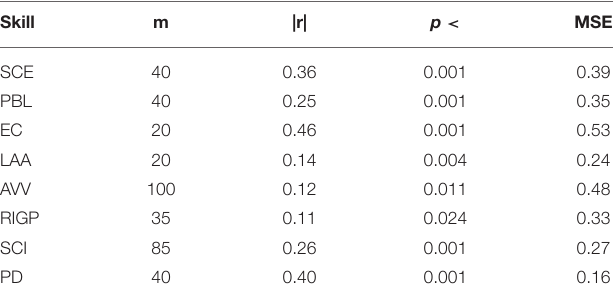
TABLE 2 | Best GP regression model results and number of clusters for each presentation delivery skill, using the audio (spoken expressions) data